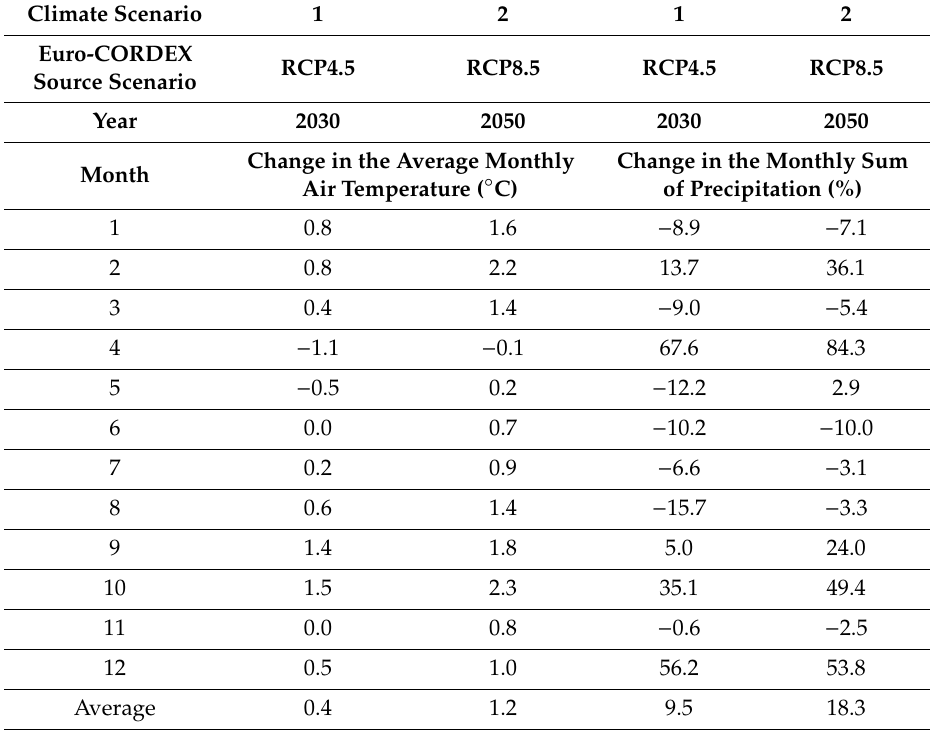
Table 5. Climate change scenarios analyzed for the Paprocany